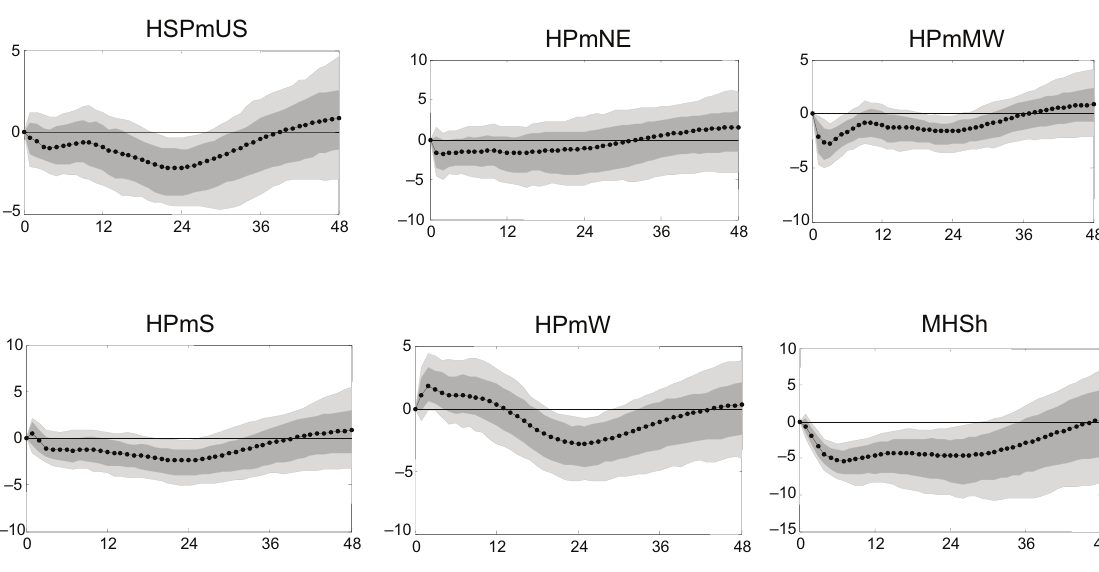
Figure 6. effect of 100-basis-point monetary policy shock on housing permits